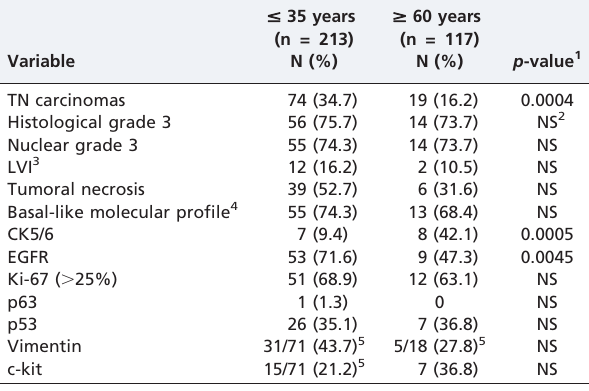
Table 2 - Pathological and immunohistochemical features of TN Breast carcinomas in younger ( # 35 years) vs. older ( $ 60 years)